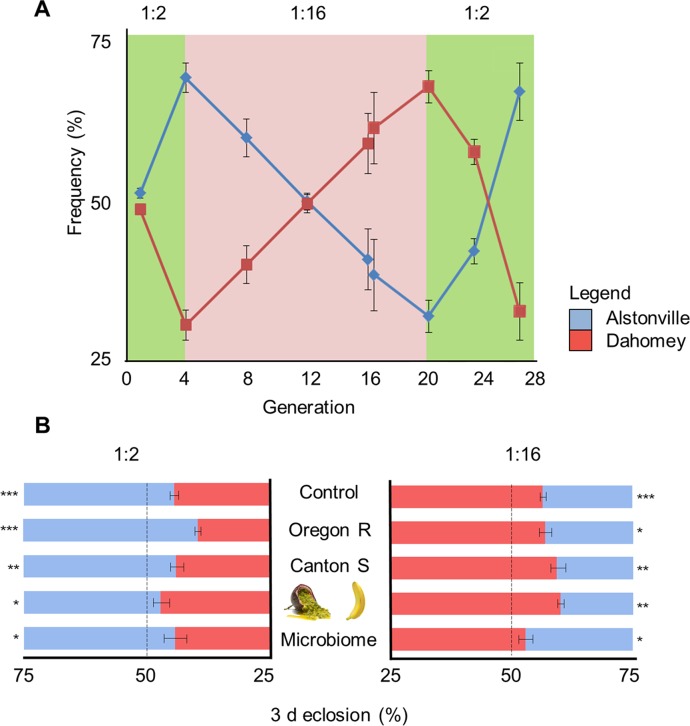
Population cages and larval development of two mitotypes.(A) Flies with Alstonville or Dahomey mtDNA were competed (n = 3 cages). Initially, the diet had a 1:2 P:C ratio. After four generations, the diet was switched to 1:16 P:C. An incubator malfunction killed all Drosophila in generation 16, so cages were re-established with a similar frequency of each mitotype. In generation 20, the diet was swapped back to 1:2 P:C. Plotted data are mean± s.e.m. mitotype/generation/cage/diet from ~80 flies/cage. (B) The number of females eclosing in 3 d was determined. The control was flies with w1118 nuclear background fed 1:2 P:C and 1:16 P:C laboratory diets (n = 29 replicates of ~80 flies/rep for the 1:2 P:C diet, and n = 48 replicates of ~80 flies/rep for the 1:16 P:C diet). First, the nuclear genetic background was replaced with Oregon R (n = 6 biological rep/mitotype/diet). Second, the nuclear genetic background was replaced with Canton S (n = 5 biological rep/mitotype/diet). Third, passionfruit and banana replaced the laboratory diets (w1118 nuclear background, P:C ratio of ~1:2 P:C and ~1:16 P:C, respectively; n = 5 rep/mitotype/diet). Finally, the microbiome obtained from wild-caught flies was introduced (w1118 nuclear background, n = 6 biological rep/mitotype/diet). The 3 d eclosion window began on day 14 for 1:2 P:C diet and day 28 d for 1:16 P:C diet. Plotted data are mean± s.e.m. * p< 0.05, ** p< 0.01, *** p< 0.001 as calculated by t-tests (see text).